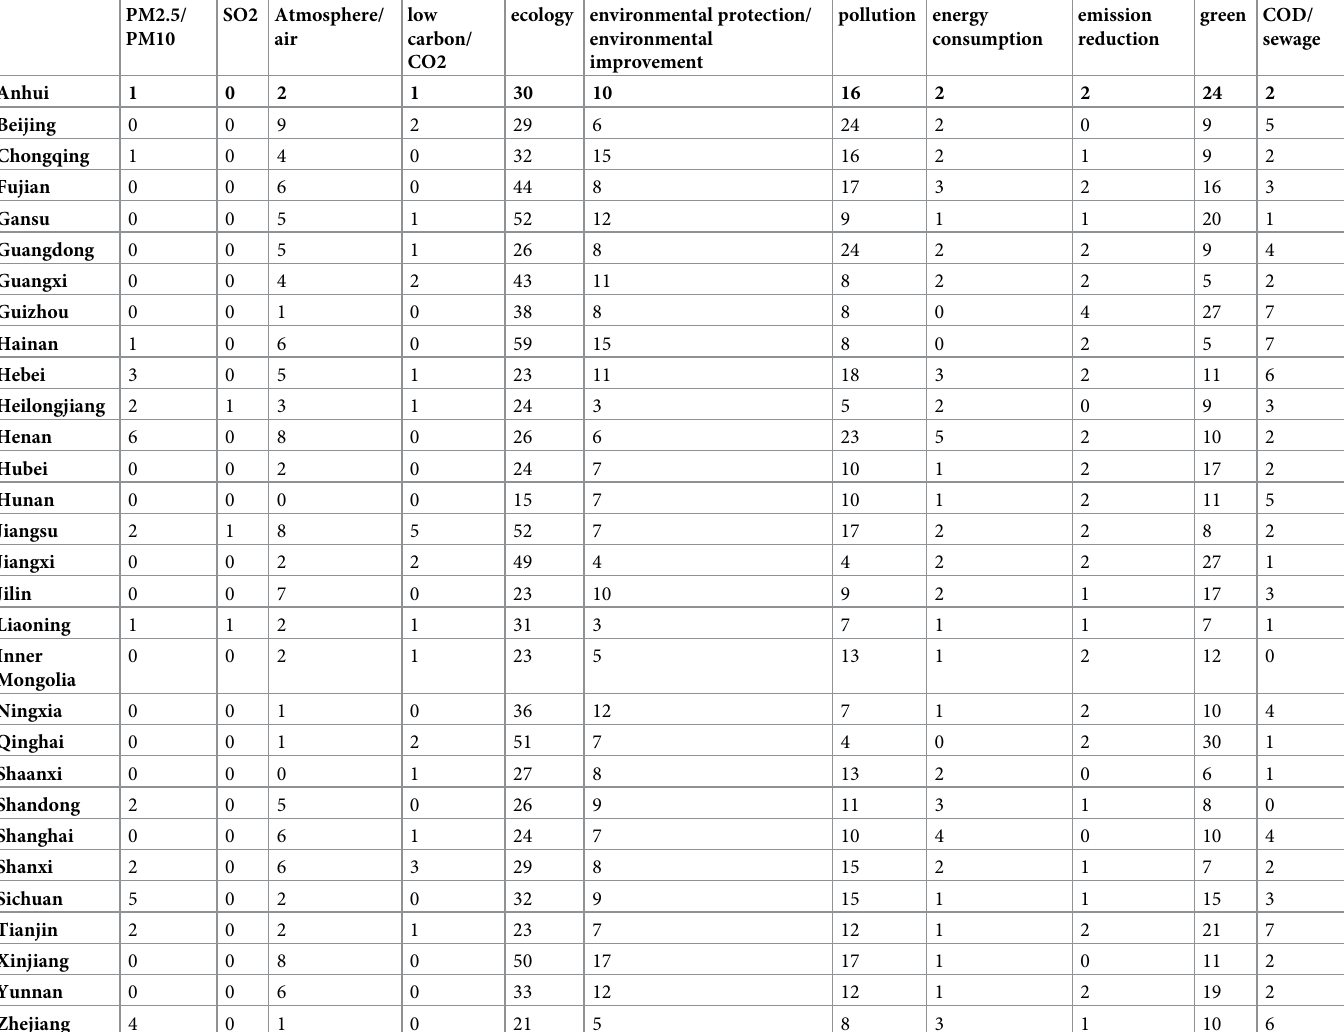
Table 2. Statistics on the frequency of environmental policy vocabulary of government work reports in